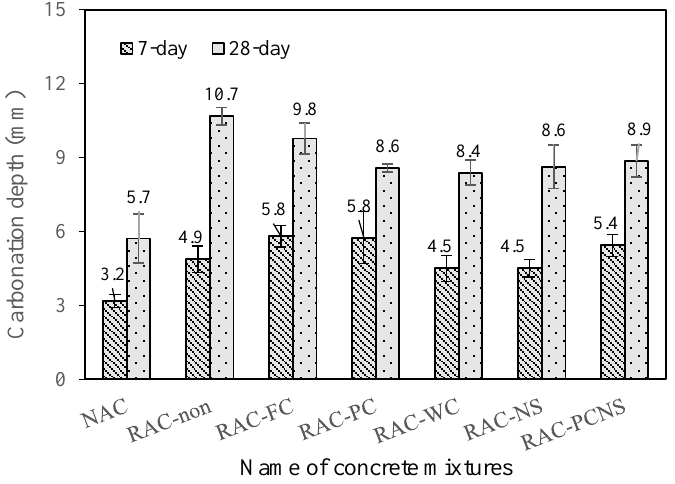
Figure 12. Carbonation depth of hardened concrete.